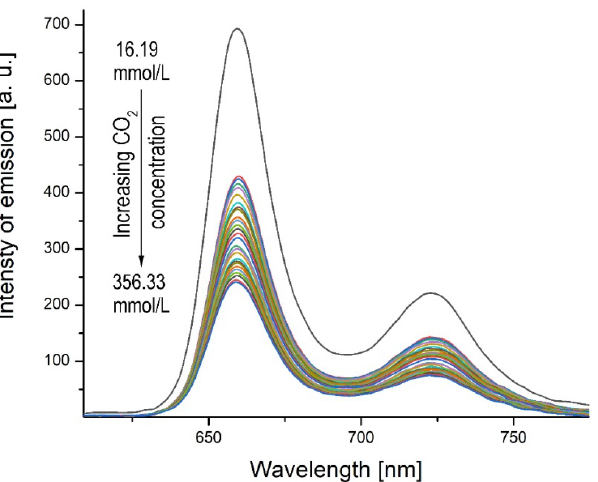
Figure 6. Overlapped emission spectra showing the quenching of the fluorescence due to interaction between (5-COOH-3MPP)-k-carrageenan and CO 2 gas, λ ex = 432 nm, excitation slit = 10 nm, emission slit = 7.5 nm and scan speed = 1200 nm/min.